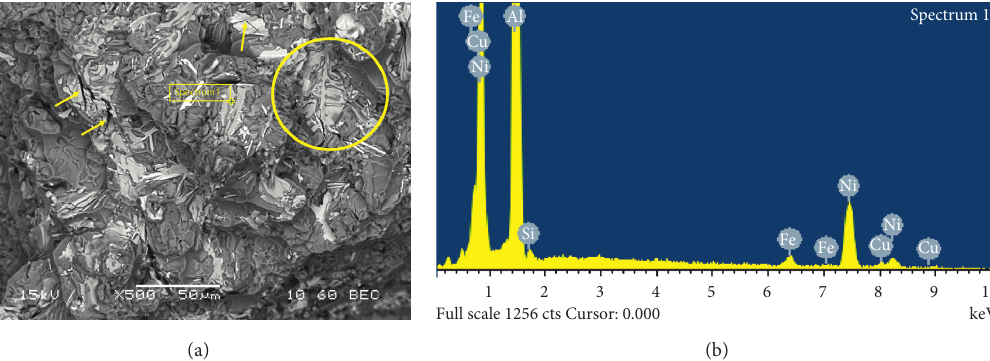
Figure 6: SEM images of T6-treated M2S alloy after stabilization at 250 ° C for 1 hour: (a) BSE image showing microcracks associated with Ni-rich phases and (b) EDS spectrum corresponding to the point of interest in (a).